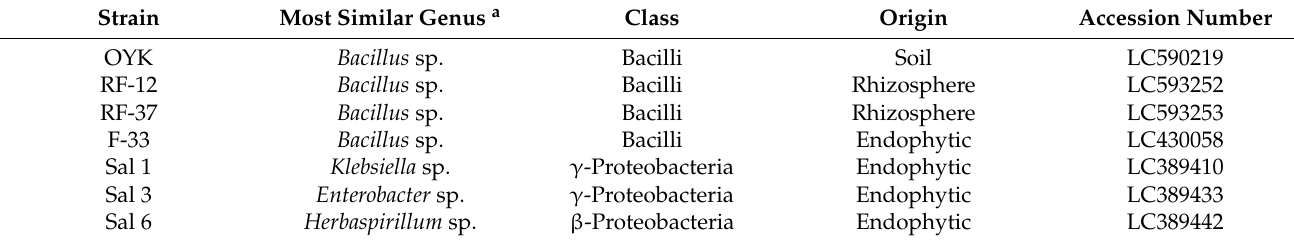
Table 1. Bacterial isolates used in this study